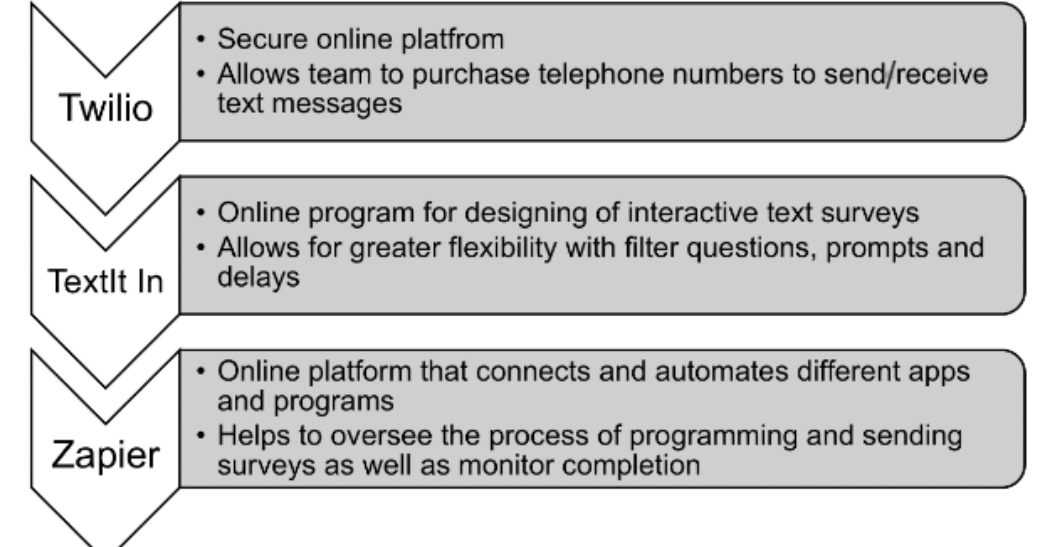
Figure 2. Readily available platforms used in redesigning the